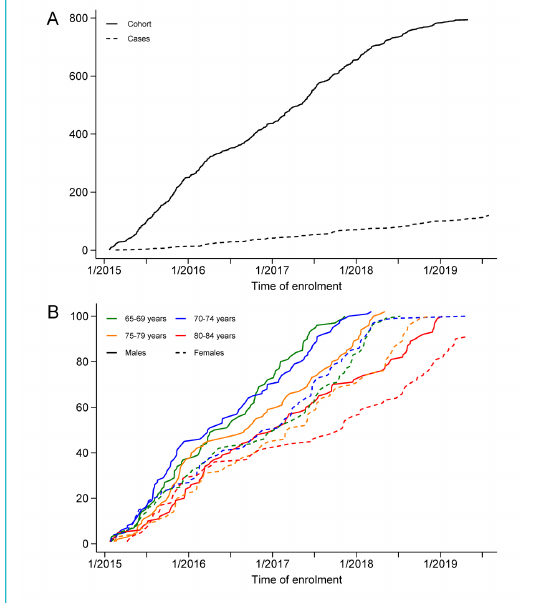
Figure 2: Cumulative recruitment over time overall for the cohort study and for the cases of the case-control study (top) and by age and sex subgroups for the cohort study